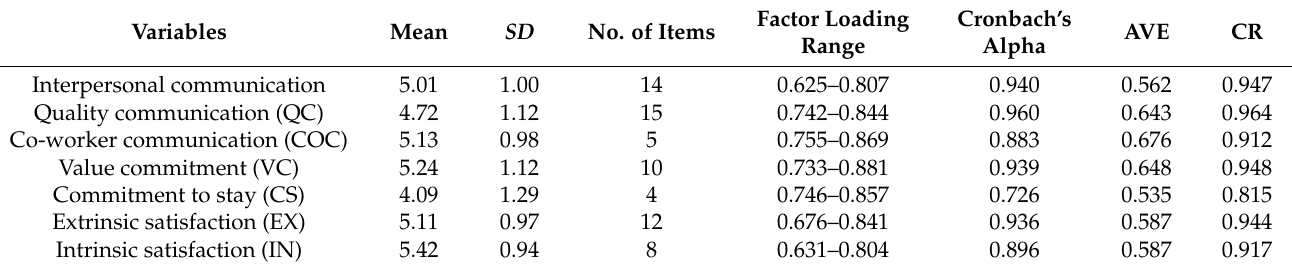
Table 3. Descriptive statistics on study